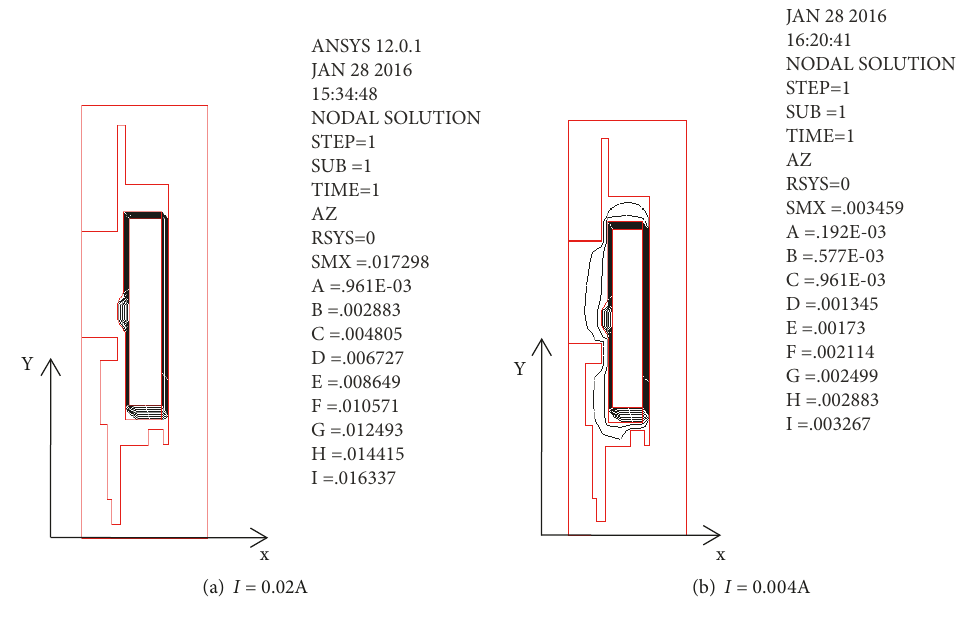
Figure 4: Distribution of magnetic flux lines.